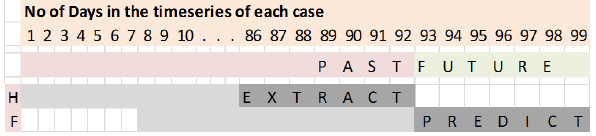
Fig. 1. Chart on computational strategy. Each examined case con- sists of two steps, an H -step and an F -step. H -step: H denotes the past period (last three-month time-series: from t 0 − 90 days to t 0 ) where each modelled time-series is decomposed into its spectral components and EXTRACT denotes the last 7-day period (from t 0 − 7 days to t 0 ) of H where the spectral ensemble is validated against the observed spectral components, with respect to the RMSE, to identify the models that produced the optimal spectral components. F -step: F denotes the shifted-by-one-week-period including a fore- cast week at the end (from t 0 − 83 days to t 0 +7 days) where the spectral components of the model id’s identified in the H -step of the case are re-calculated and summed up (kz model) and finally the kz model prevision during the PREDICT week (from t 0 to t 0 +7 days) is validated against the observations over the future 7-day